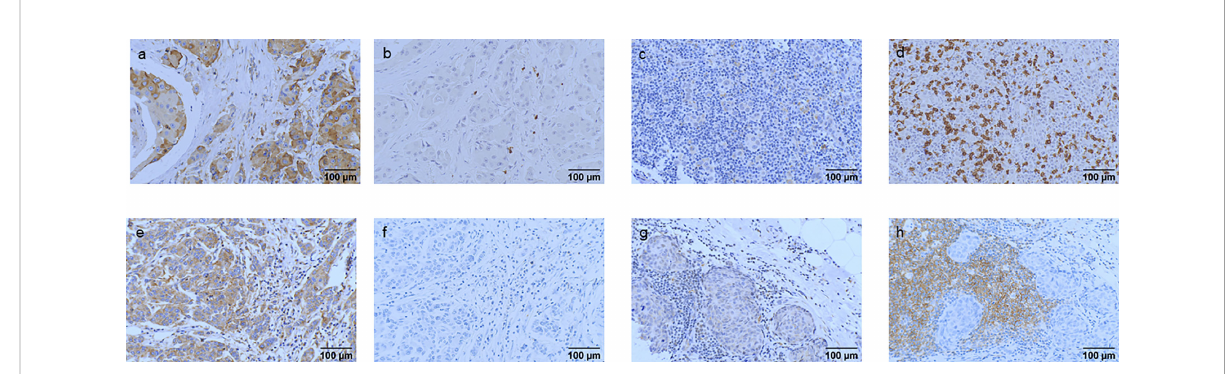
FIGURE 7 IGF2R expression association with CD8 + TILs and CD19 + TILs. (A, B) The patients with IGF2R-positive expression and a low percentage of CD8 + TILs. (C, D) The patients with IGF2R-negative expression and a high percentage of CD8 + TILs. (E, F) The patients with IGF2R-positive expression and a low percentage of CD19 + TILs. (G, H) The patients with IGF2R-negative expression and a high percentage of CD19 +